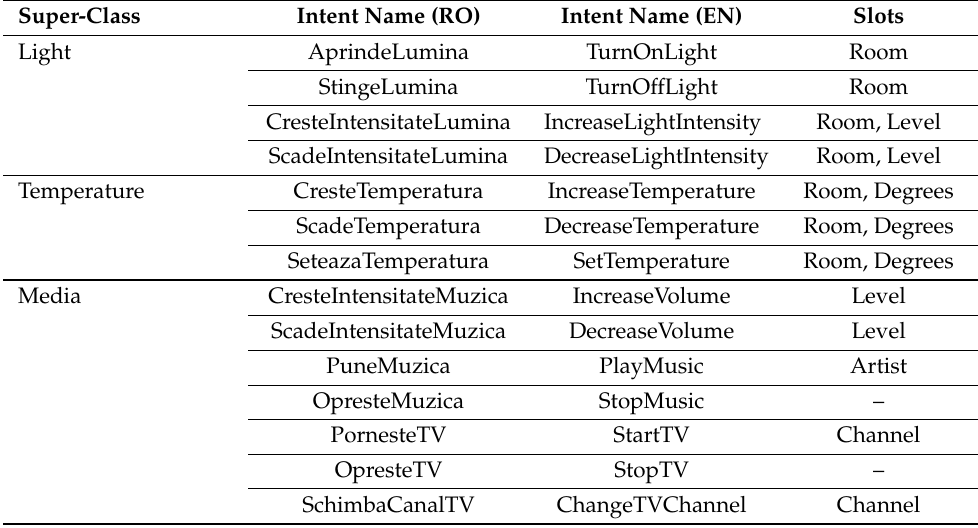
Table A1. Intents and their corresponding slots for the home assistant scenario.